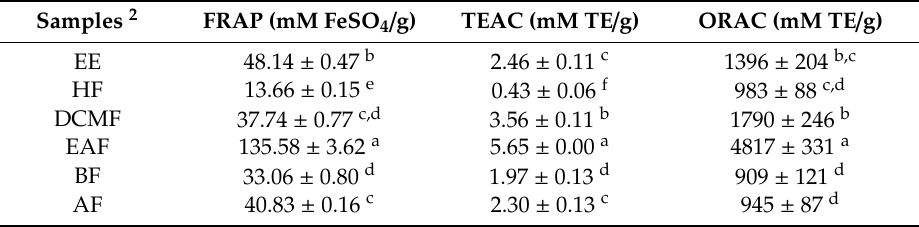
Table 4. FRAP, TEAC, and ORAC values of Rumex crispus L. root extracts and fractions 1 . Samples